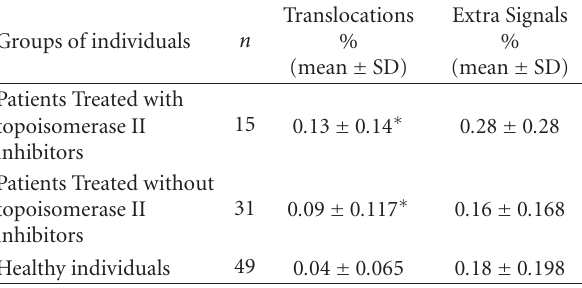
Table 3: Mean frequency of MLL translocations and extra signals obtained for ALL survivors and healthy individuals (taken from